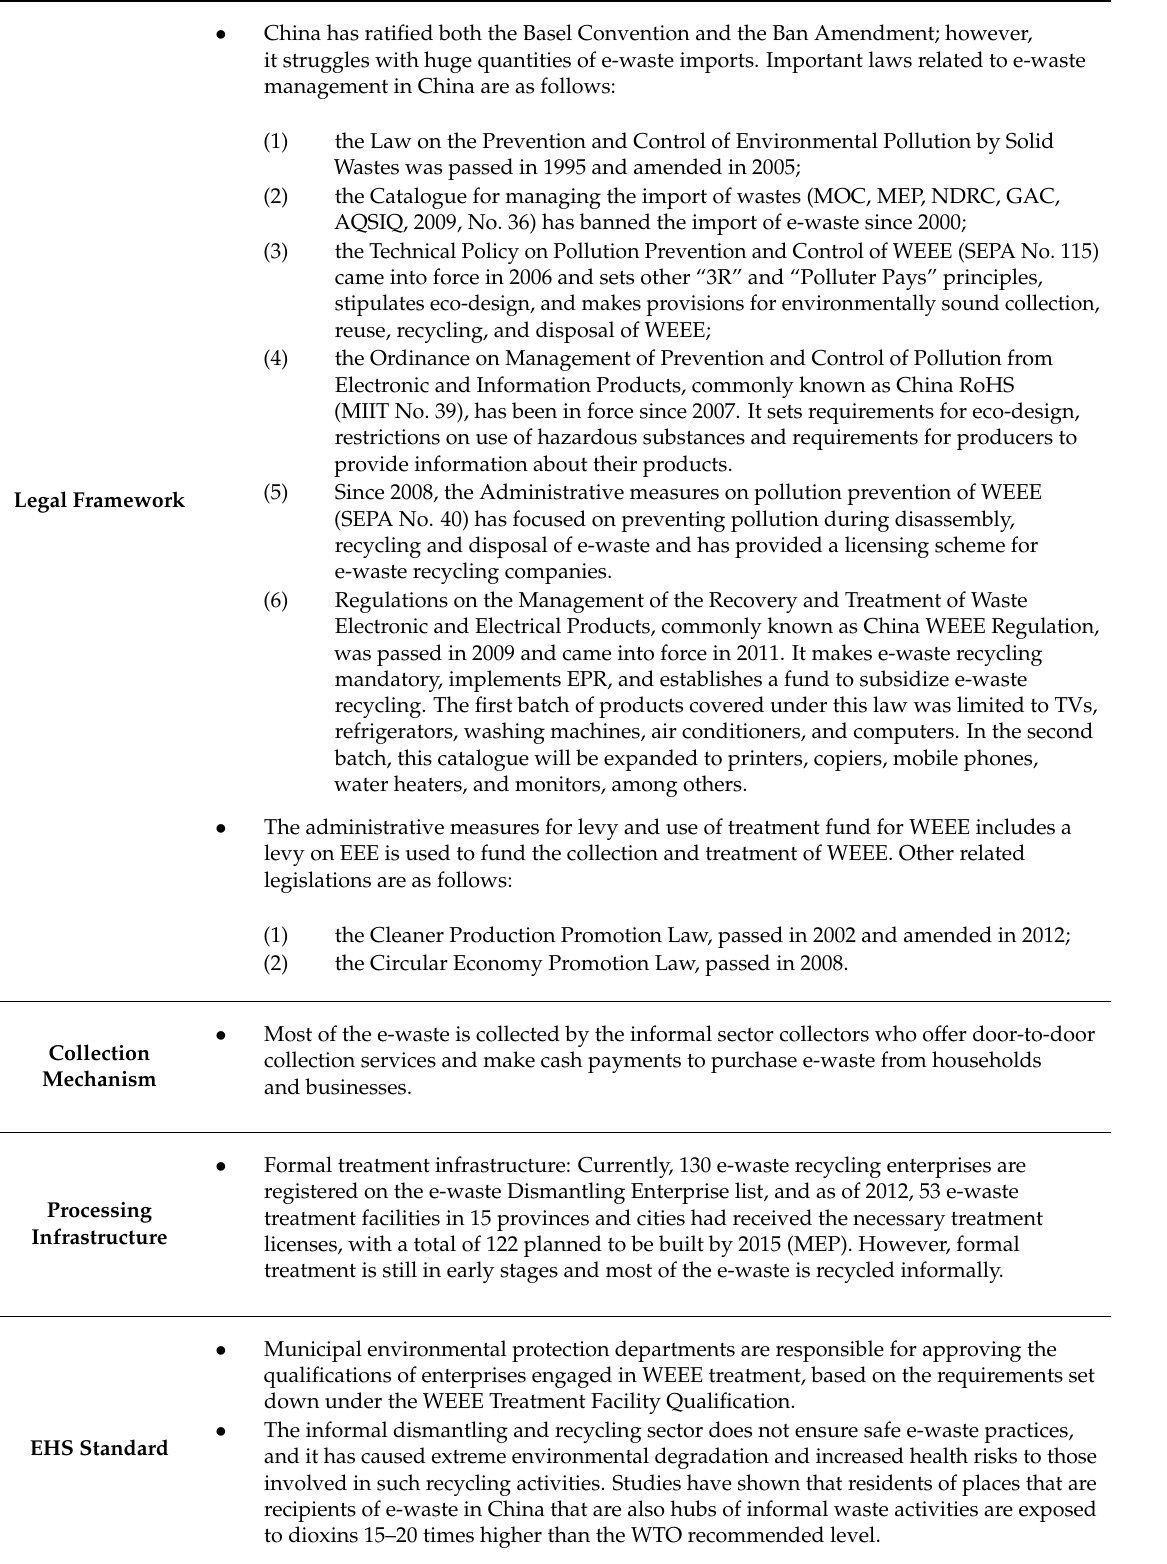
Table 4. Summary of WEEE management framework in Mainland China [32], p.